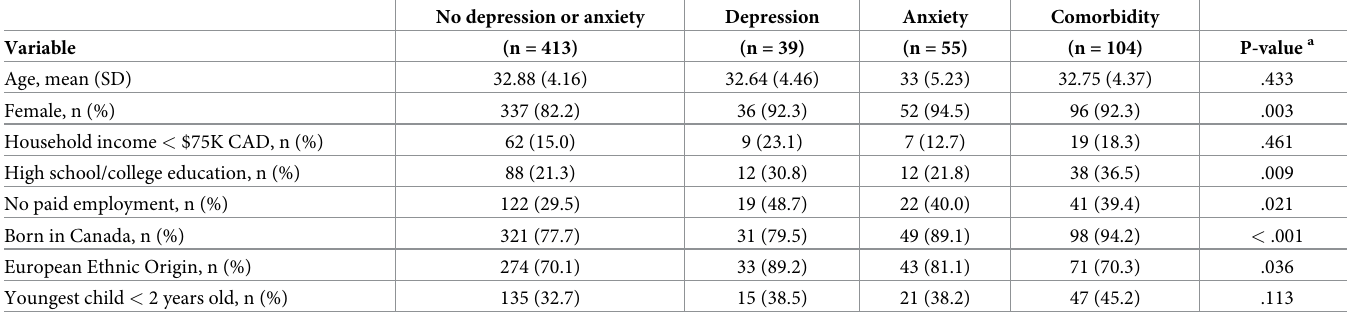
Table 1. Characteristics of individuals with depression, anxiety, and comorbidity compared to those without mental